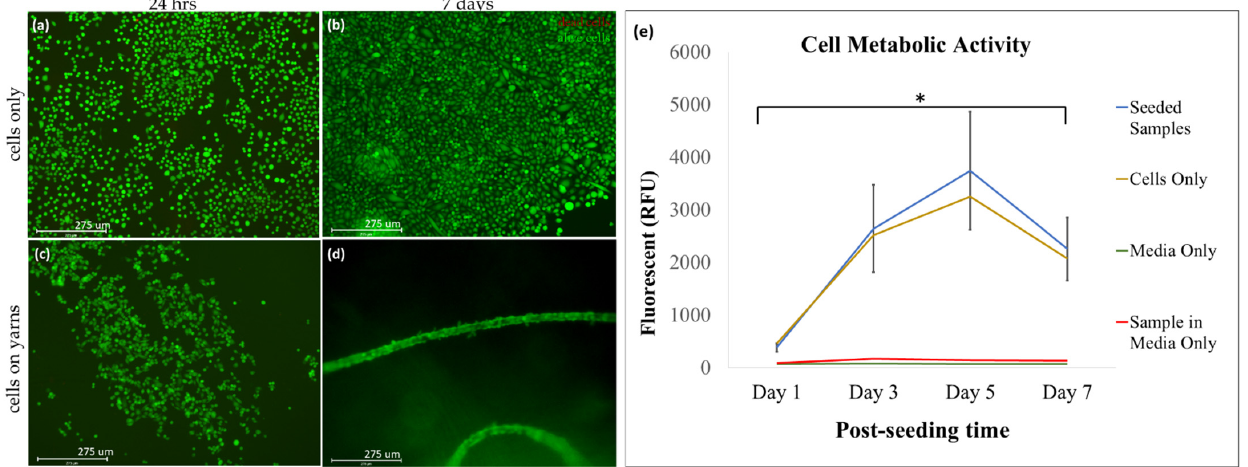
Figure 5. High biocompatibility of collagen yarns is observed. Viability of NIH 3T3 cells ( a ) seeded on collagen yarns. The green signal indicates live cells, and the red signal indicates dead cells. The live/dead assay of the seeded samples at 24 hours ( c ) and after 7 days ( d ). The cell-only controls at 24 h and 7 days are also shown ( a , b ). We see evidence of the cells adhering and proliferating along the length of the fiber for at least 7 days, indicating the biocompatibility of the collagen yarns ( n = 10). The results from the live/dead assay were confirmed and quantified with the alamarBlue assay ( e ). We observed an increased in metabolic activity that was correlated to increased proliferation in the cells that were seeded on our collagen yarns ( e , blue positive control (cells only in yellow) and the negative controls (medium-only in green and sample in medium in red)). A significant increase in metabolic activity was observed in the cells seeded on collagen yarns from day 1 to day 5 (* p < 0.0001). The error bars show the standard deviation ( n = 9).